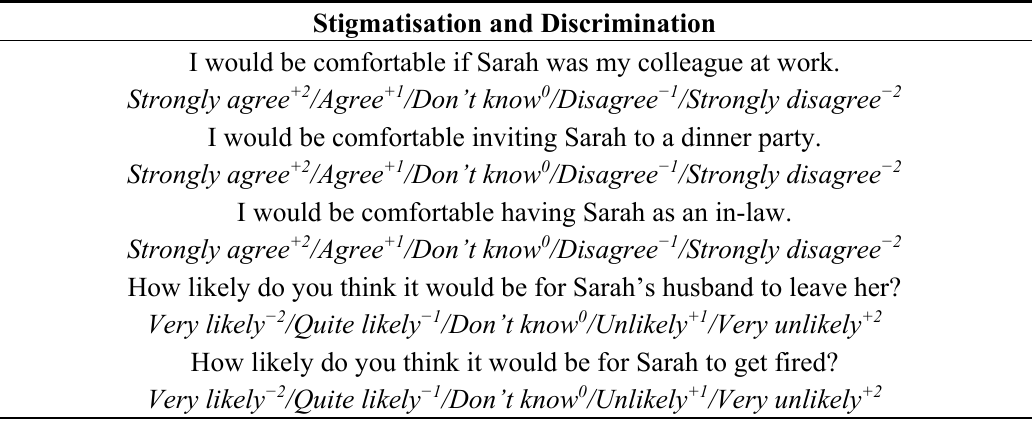
Table 1. Questions used to measure levels of stigma based on the vignette. Stigmatisation and